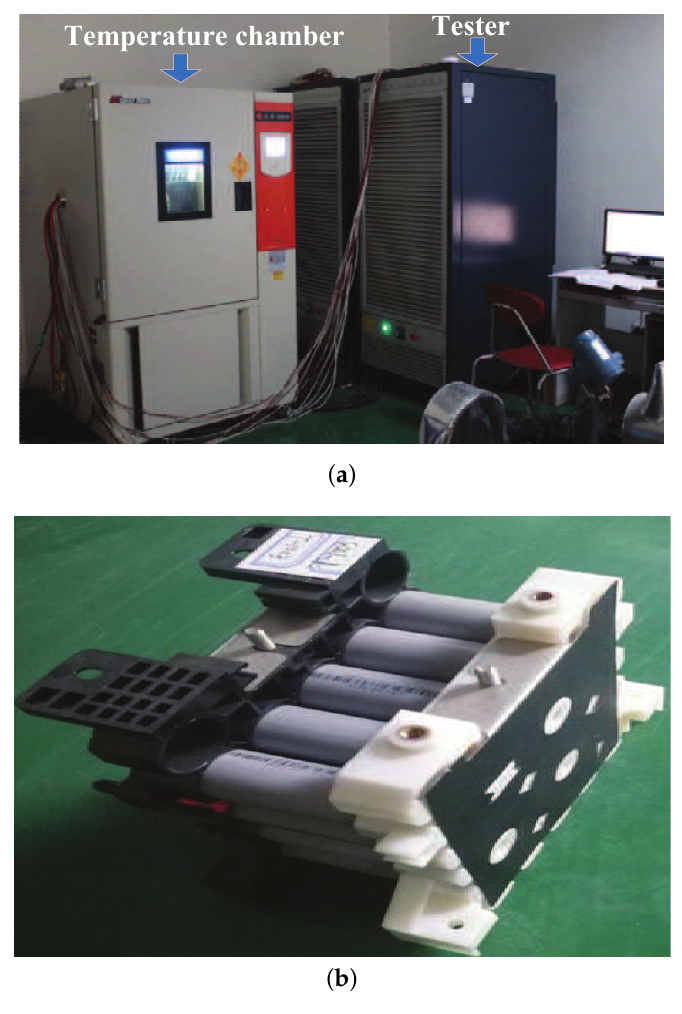
Figure 3. Test bench: ( a ) MKL battery tester and ( b ) 32 Ah